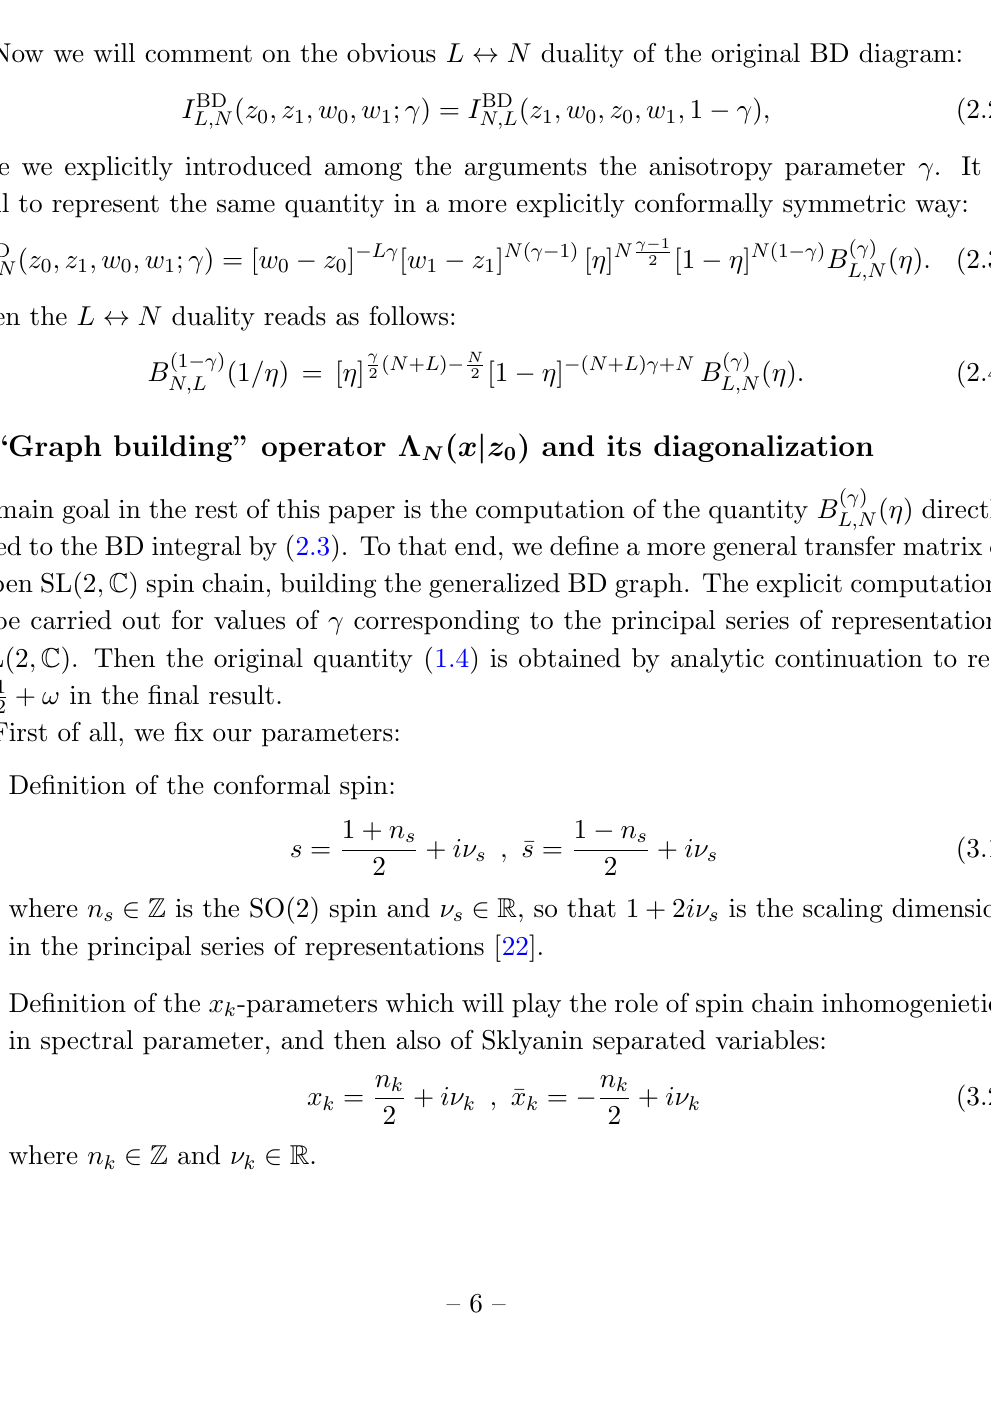
Figure 3 . The \comb" transfer matrix for an open spin chain of length N ( N = 3 on the picture) is applied L times to itself as an integral kernel. The resulting structure is a Fishnet of the type of (cid:12)gure 2(right) with L + 1 vertical and 3 horizontal